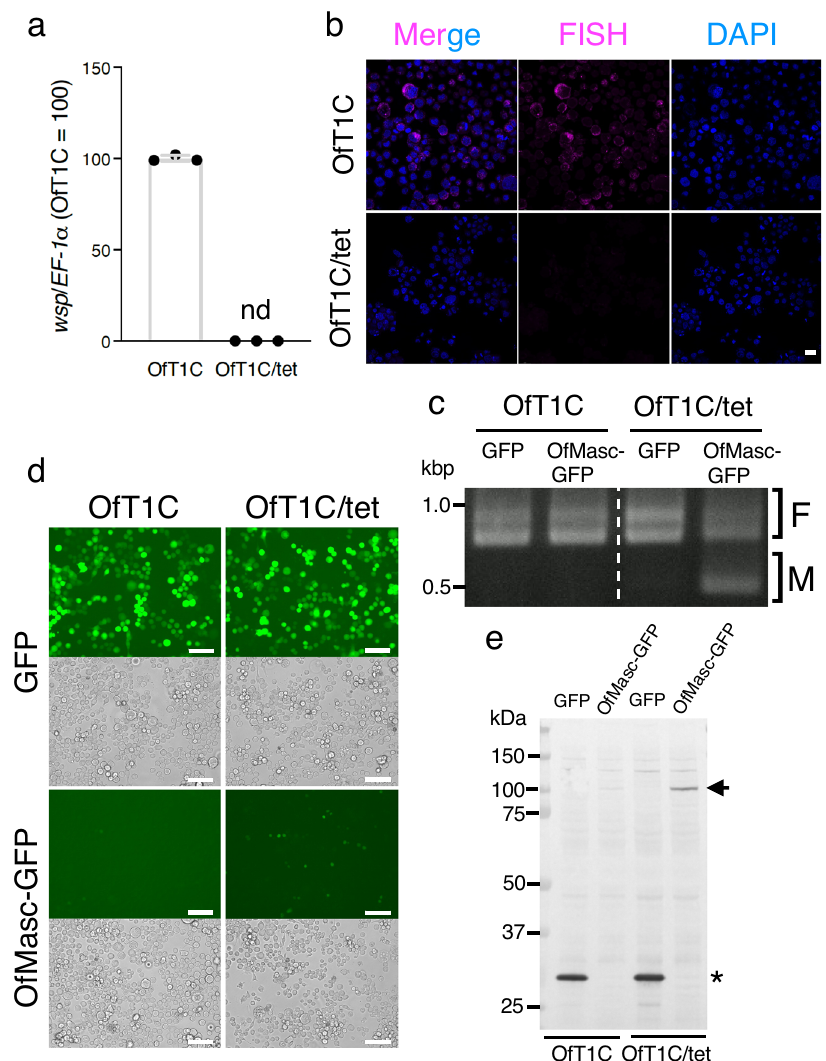
Fig. 1 | Establishment of cell lines from w Fur-infected O. furnacalis embryos. a Wolbachia densityinOfT1CandOfT1C/tetcells. Wolbachia densitywasestimated by qPCR of wsp and normalized by EF-1 α . Data shown are means±SD of triplicate measurements.Similarresultswere obtained intwo independent experiments. nd, notdetected. b FISHanalysisof Wolbachia inOfT1CandOfT1C/tetcells. Wolbachia were detectedby a 16SrRNA FISHprobe. The cells werealso stained with DAPI for DNA. Bar, 20 µ m. Similar results were obtained in two independent experiments. c Splicingpatternsof Ofdsx .OfT1CandOfT1C/tetcellsweretransfectedwith GFP or OfMasc-GFP cDNA, and Ofdsx splicing was investigated. The F and M indicate female-andmale-typesplicingof Ofdsx ,respectively.Similarresultswereobtained